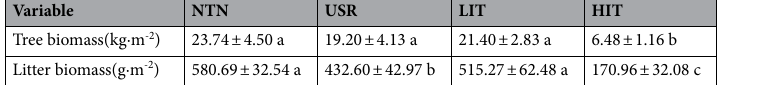
Table 3. Tree and litter biomass in P. massoniana stands under different forest management practices. Means ± standard deviations (n = 3) are shown, and different letters shown in the same row denote significant differences between the different forest management systems at P < 0.05. NTN no thinning stand, USR understory removal stand, LIT light-intensity thinning stand, HIT heavy-intensity thinning stand.